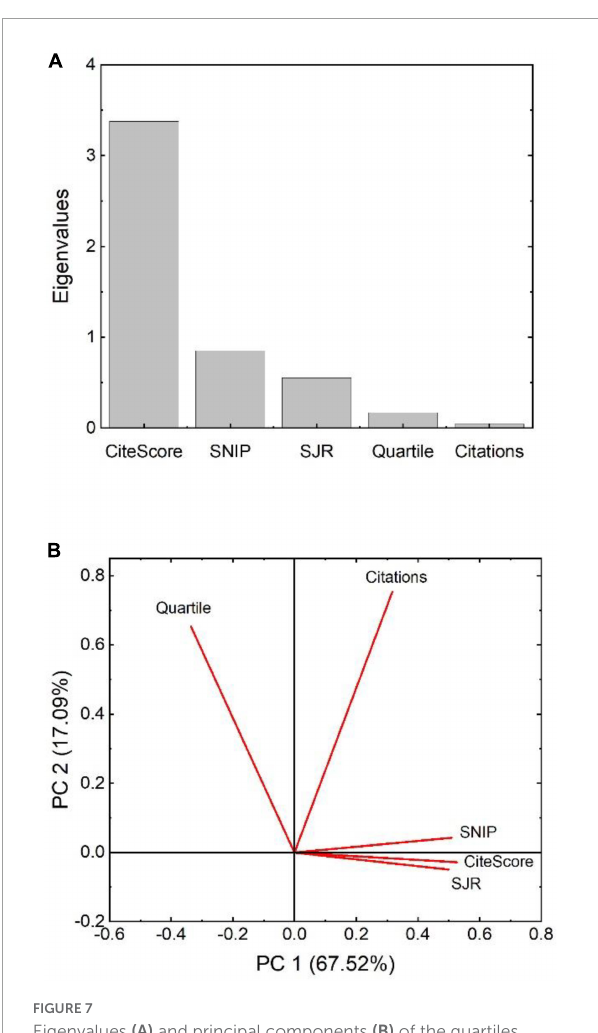
FIGURE7 Eigenvalues (A) and principal components (B) of the quartiles, citations, SNIP, SJR, and CiteScore of all the publications by Ecuadorian Universities.